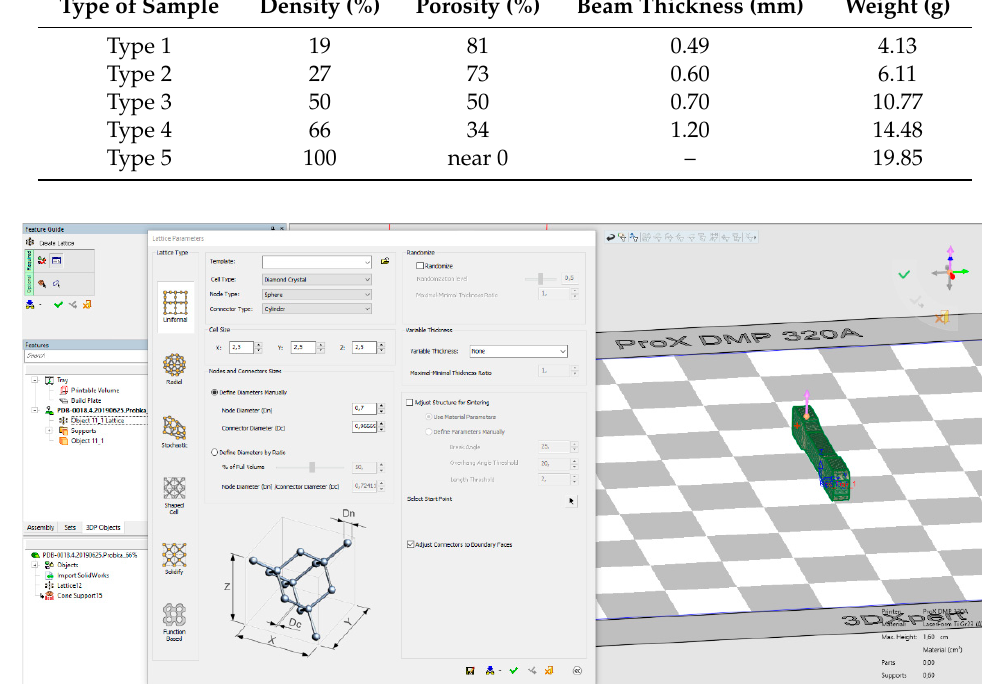
Figure 1. 3DXpert interface, where the diamond structure of a sample with different porosities was designed (3DXpert for SolidWorks).